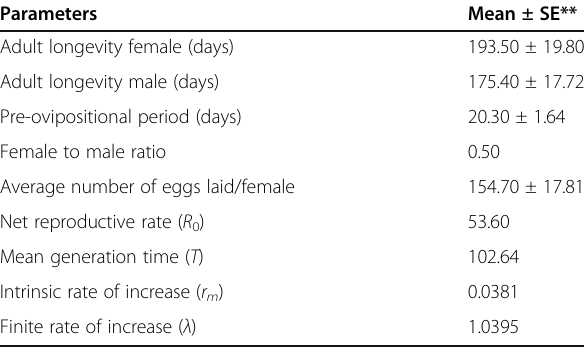
Table 4 Biology and life table parameters of C. brachylobus feeding on B.